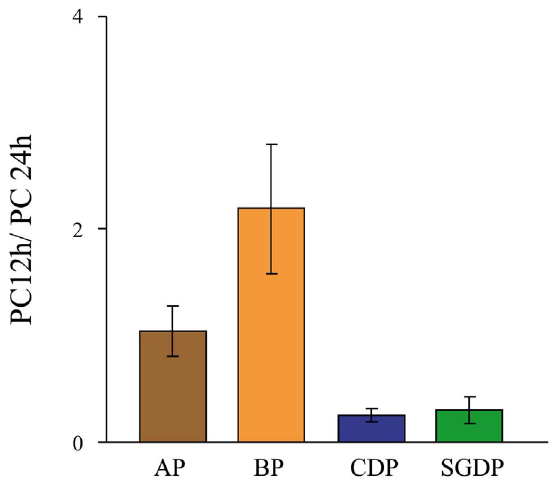
Figure 7. Comparing the relevance of 12 h and 24 h at-sea activity patterns. The ratio of the power content of the 12 h and 24 h harmonics obtained by Fourier analysis (mean and standard deviation), indicating the relevance of the 12 h activity bout to the 24 h pattern, for (A) Antarctic prion, (B) blue petrel, (C) common diving petrel and (D) South Georgian diving petrel.